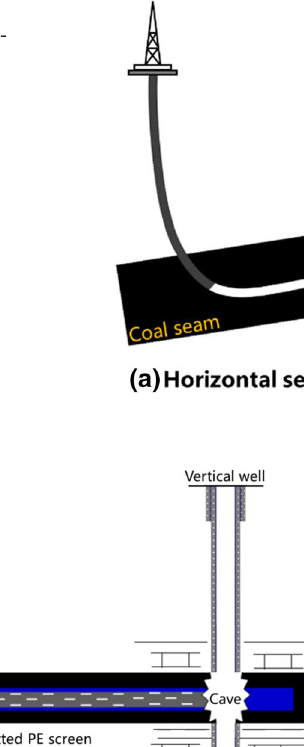
Fig. 5 Schematic of CBM L-shaped horizontal well, modi- fied from Tao et al. (2019)